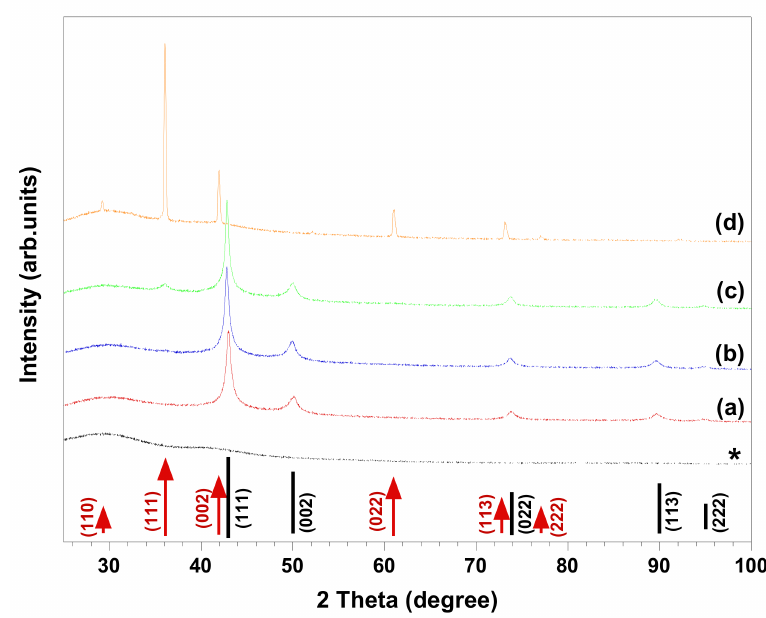
Figure 4. XRD patterns of synthesized materials in 0.01 M Cu(II)—0.01 M EDTA solutions containing ( a ) 0.01 M CTAB, ( b ) 0.01 M DoTAC, ( c ) 0.01 M SDS, and ( d ) 0.01 M DDAO. The positions of the expected Bragg peaks from copper (black lines), and cuprous oxide (red arrows) are marked and labeled with their respective Miller indices. The diffraction pattern denoted by * in the plot stems from the type RA Millipore membrane filter used to separate synthesized material by simple vacuum